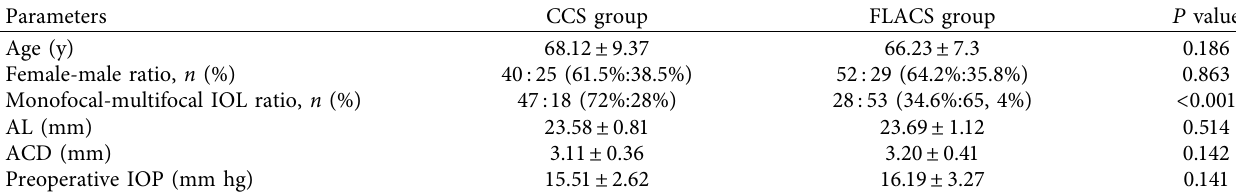
Table 1: Demographic data and characteristics of enrolled